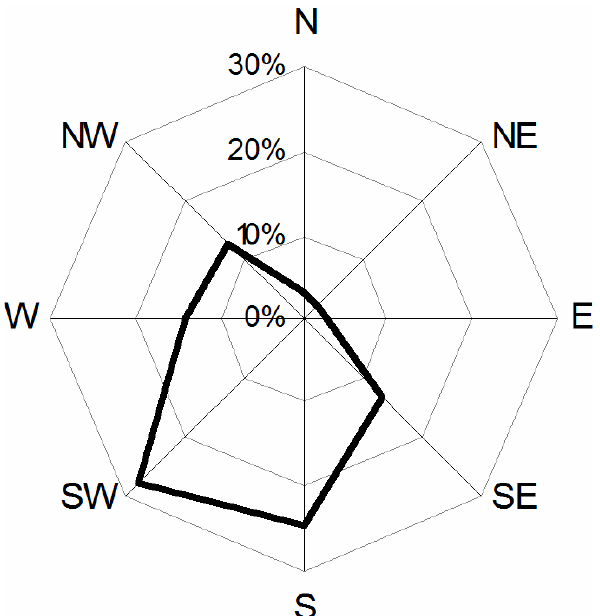
Fig. 10. Percentage of rainfall in Mafra (1783–1787) by wind di- rection, according with Velho’s data (Taborda et al., 2004). Figure 10. Percentage of rainfall in Mafra (1783-1787) by wind direction, according with Velho’s data (Taborda et al., 2004).